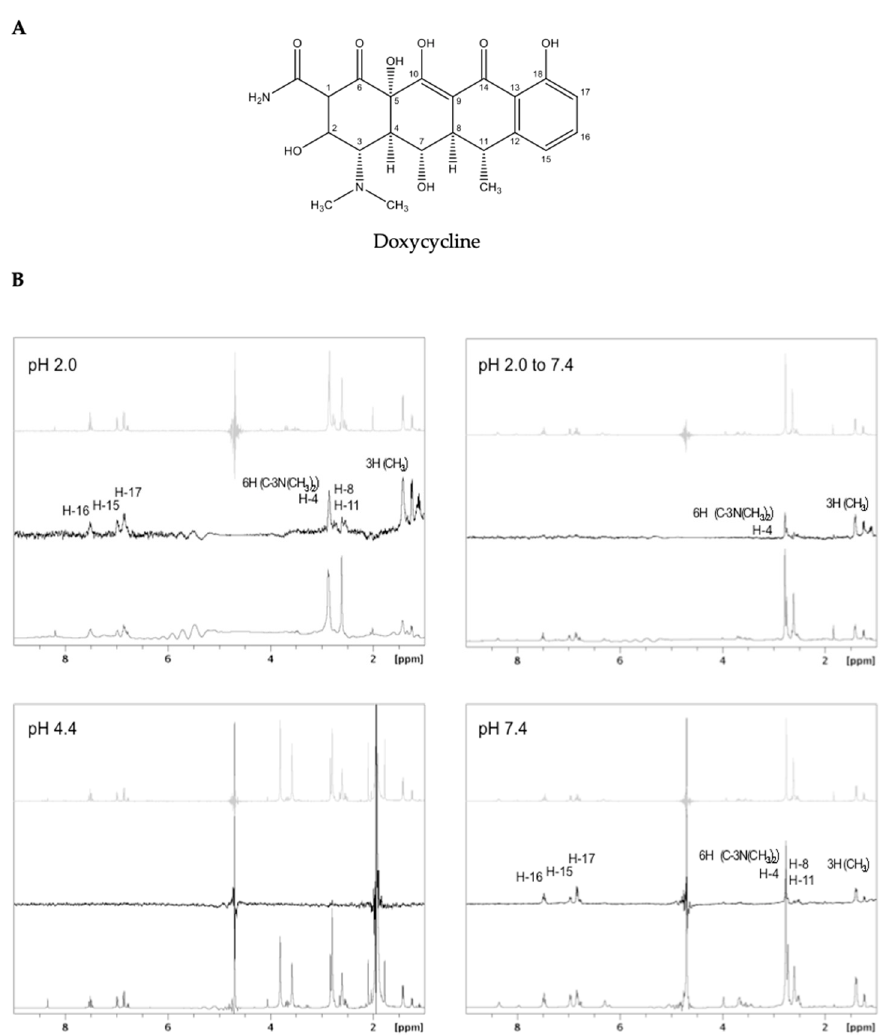
Figure 3. ( A ) Molecular structure of doxycycline and ( B ) 1 H STD NMR of doxycycline (2 mM) in the presence of preformed TTRwt fibrils (20 µ M) assembled at pH 2.0 (pH 2.0), pH 2.0 that underwent pH adjustment to 7.4 (pH 2.0 to 7.4), pH 4.4 (pH 4.4), and assembled by heating at pH 7.4 (pH 7.4). The reference 1 H NMR spectrum of doxycycline at the corresponding pH is represented in light grey, the 1 H STD NMR spectrum is represented in black, and the off-resonance spectrum is represented in